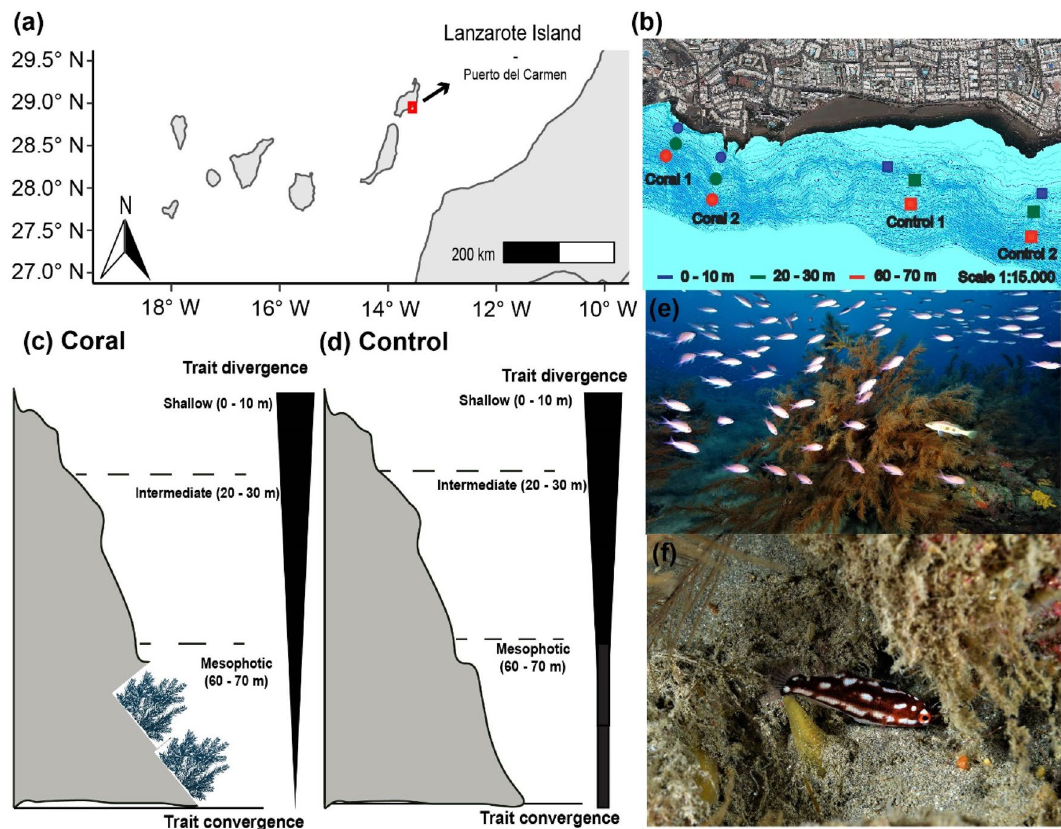
Figure 1. ( a , b ) Map of the study area, including the distribution of coral and control sites for each depth strata. ( c , d ) Conceptual diagram illustrating changes in the degree of trait divergence vs. convergence at coral and control sites. The width of the arrow indicates the magnitude of convergence at the mesophotic strata. ( e , f ) Fish assemblages associated with black coral forests in the study region, including ( e ) Anthias anthias and Serranus atricaudata , and ( f ) Lapanella fasciata . Photos: Fernando Espino. ( a ) Map sourced from ‘rnaturalearth’ R package 80 . ( b ) Map sourced from GRAFCAN (https:// visor. grafc an. es/ visor web/).